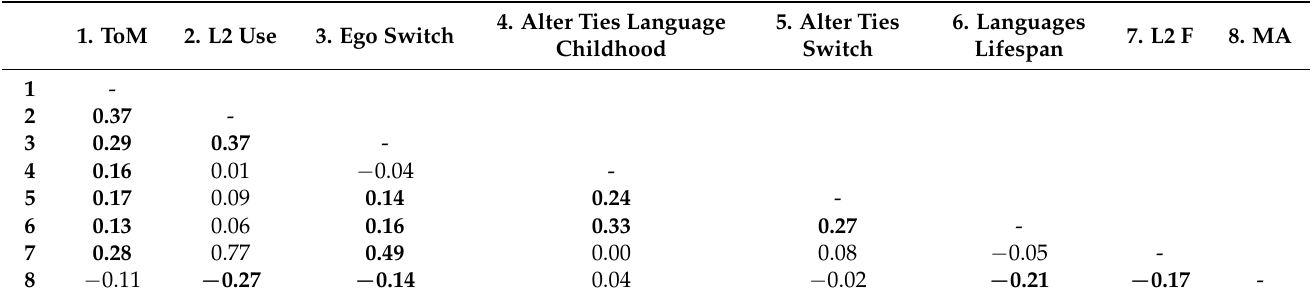
Table 3. Bivariate correlations among main